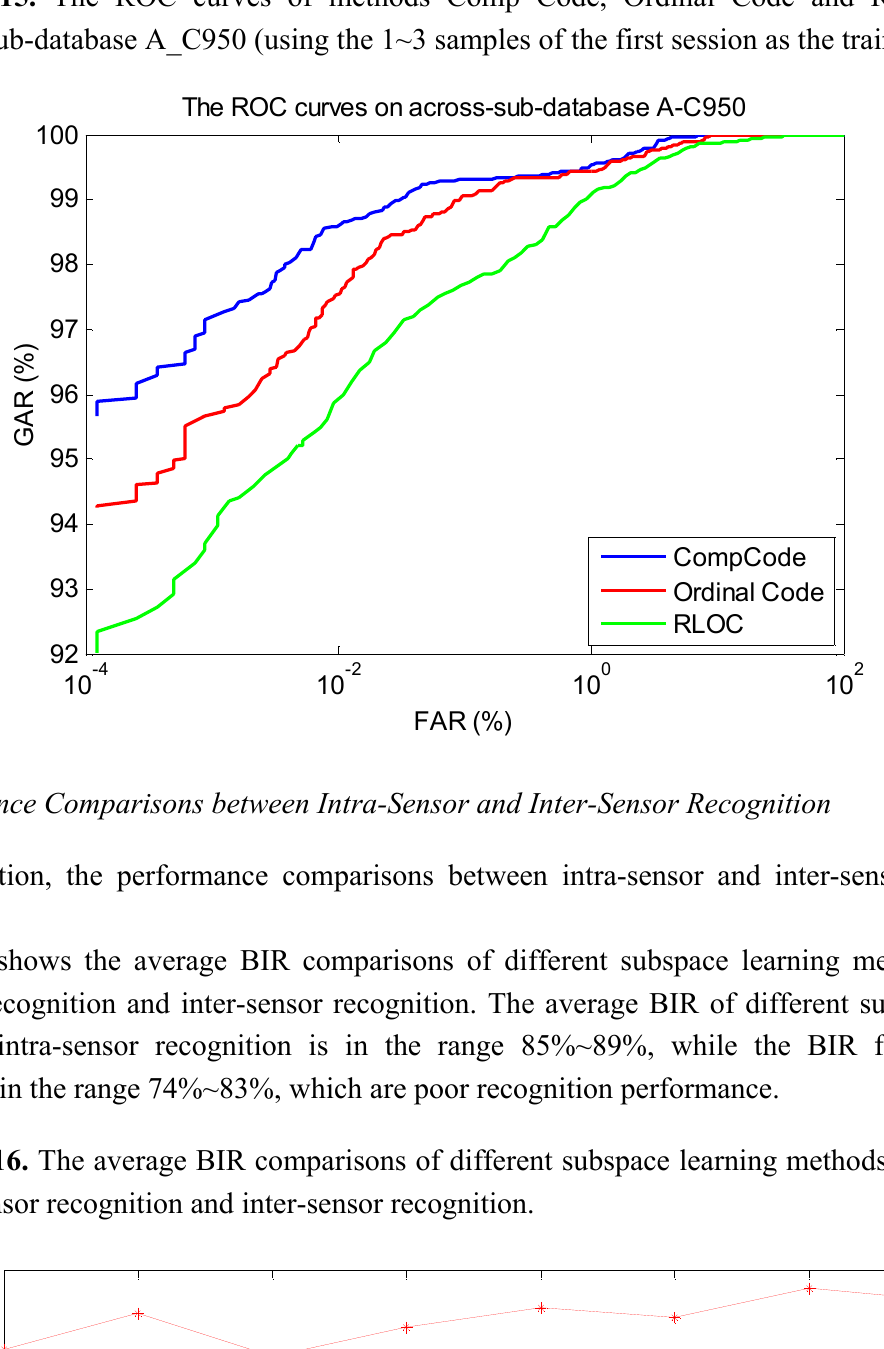
Figure 15. The ROC curves of methods Comp Code, Ordinal Code and RLOC on across-sub-database A_C950 (using the 1~3 samples of the first session as the training set).